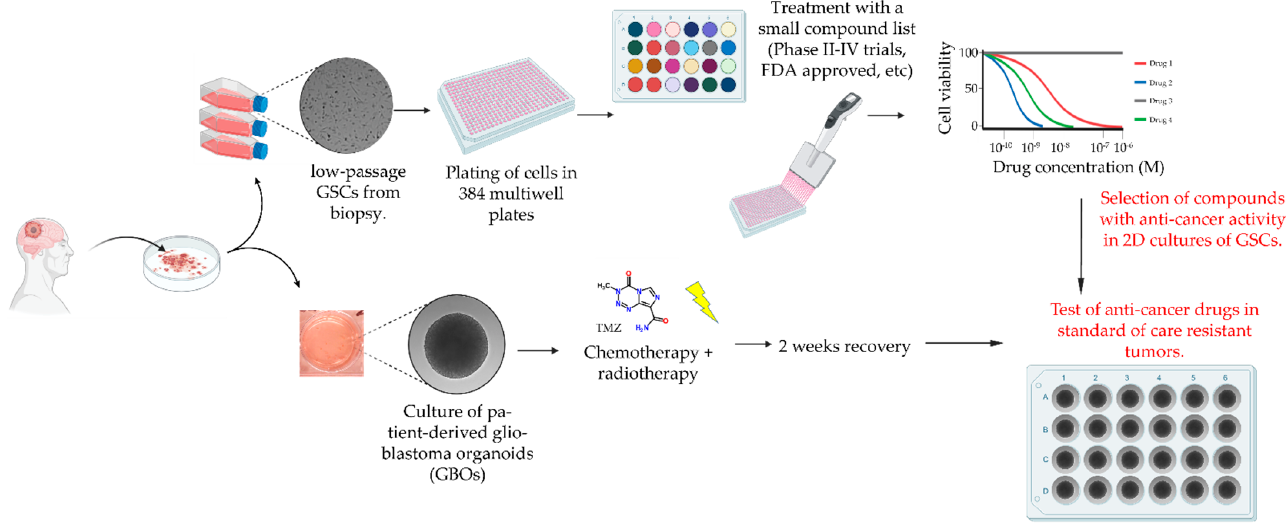
Figure 3. Drug screening pipeline in matched 2D and 3D patient-derived in vitro models for glioblastoma.